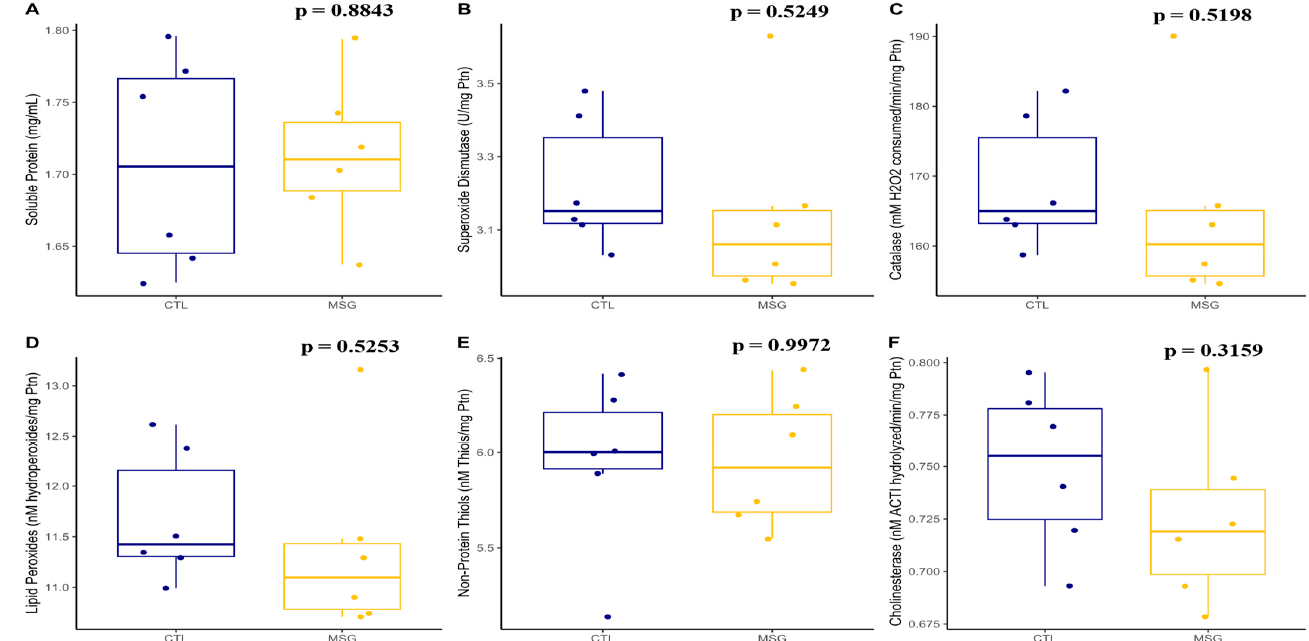
Figure 7. Graphs related to skeletal muscle antioxidant system in PND15: ( A ): soluble proteins (mg/mL); ( B ): superoxide dismutase activity (U/mg protein); ( C ): catalase activity (mM H 2 O 2 con- sumed/min/mg protein); ( D ): lipid peroxides (nM hydroperoxides/mg protein); ( E ): non-protein thi- ols concentration (nM thiols/mg protein); ( F ): cholinesterase activity (nM acetylthiocholine hydro- lyzed/min/mg protein). The CTL group is represented in blue and the MSG group is represented in yellow. All data: Student’s t -test.